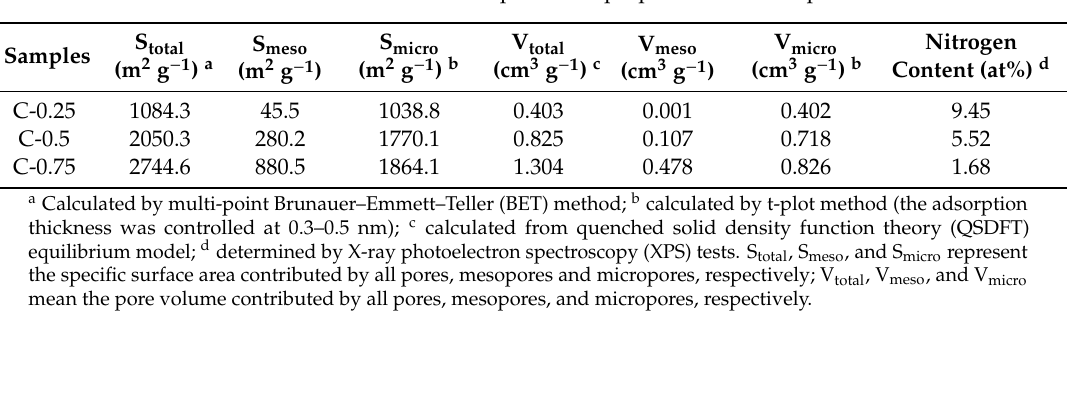
Figure 3. Characterizations of the surface chemical properties and porous texture structures. ( a ) N 2 adsorption-desorption isotherm curves, ( b ) pore size distribution, and ( c ) the cumulative pore volume. ( d ) The full-scale X-ray photoelectron spectroscopy (XPS) pectra. ( e ) Bar chart of the content variation of C, N, and O elements with the change of KNO 3 / gelatin ratios. ( f ) High resolution N1s spectra. Table 1. The textural and compositional properties of all